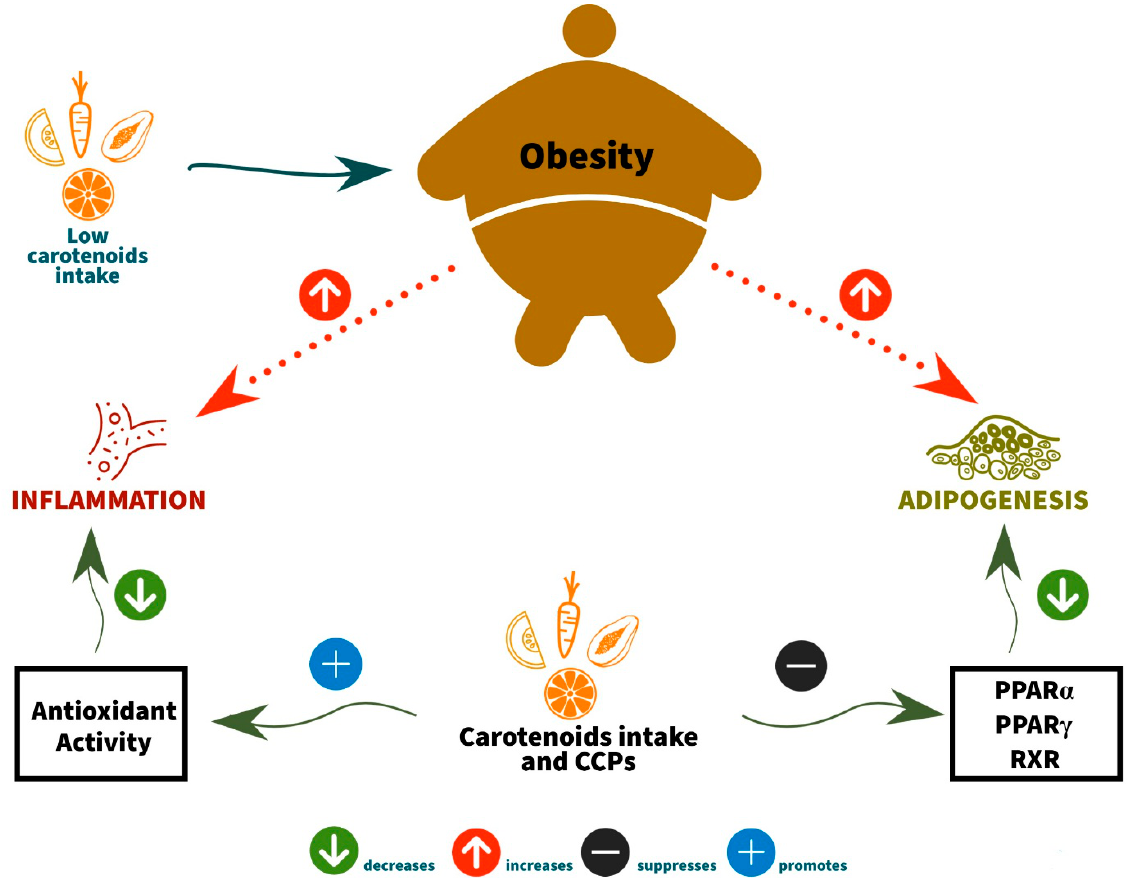
Figure 1. Relationship between carotenoids ( β -carotene, α -carotene, and β -cryptoxanthin) or their conversion products and obesity. CCPs: carotenoid converting products. PPAR γ : peroxisome proliferator-activated receptor gamma. PPAR α : peroxisome proliferator-activated receptor alpha. RXR: retinoid X receptor.